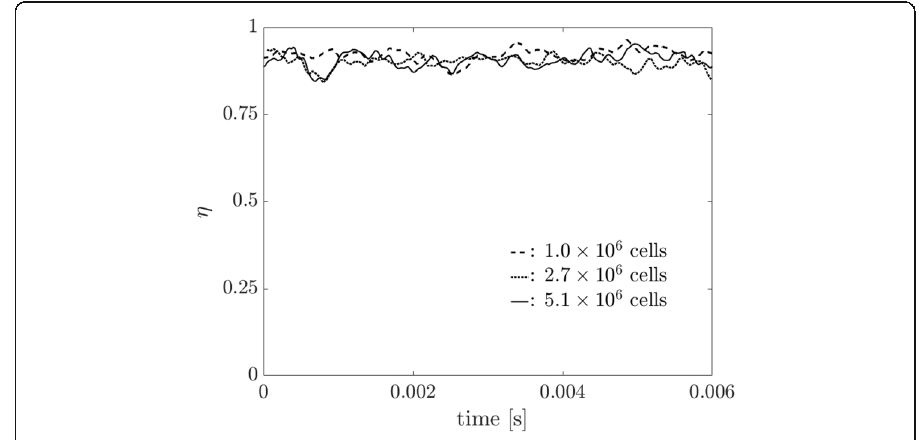
Fig. 10 The time history of η (Case-A, Model-2, Ω =